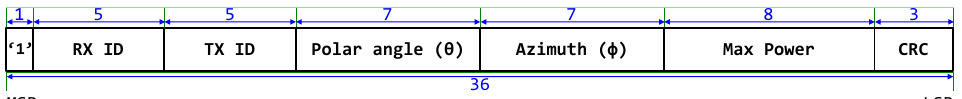
Figure 10. Laser beam direction and position as determined for each PTX channel.